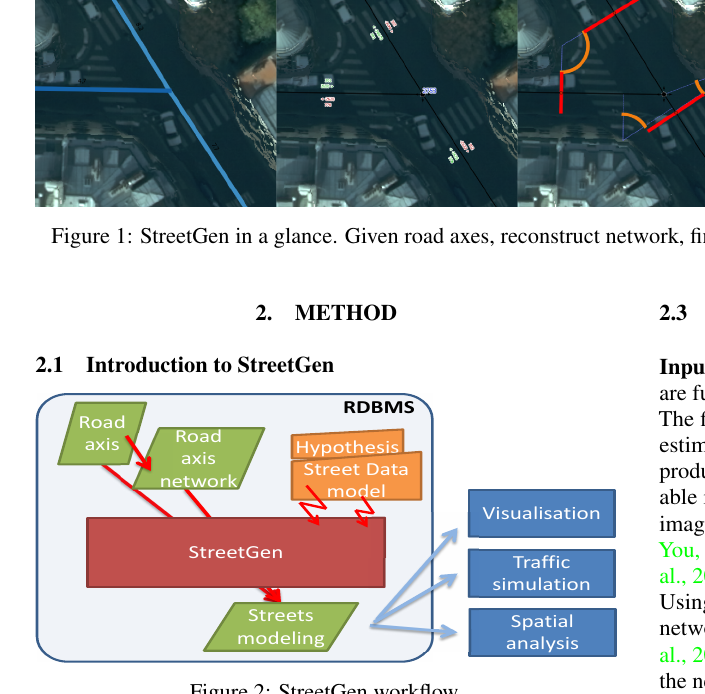
Figure 2: StreetGen